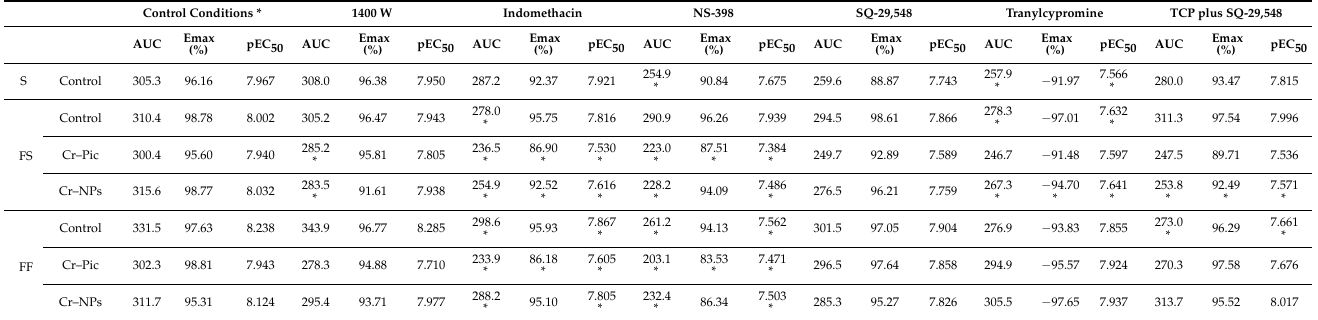
Table 2. The influence of inducible nitric oxide synthase (iNOS) inhibitor (1400 W at 1 µ M), the non- selective COX inhibitor (indomethacin at 10 µ M), the selective cyclooxygenase-2 (COX-2) inhibitor (NS-398 at 10 µ M), the thromboxane-A2 receptor (TP) antagonist (SQ-29,548 at 1 µ M), the PGI2 syn- thesis inhibitor (tranylcypromine, TCP at 10 µ M), or TCP plus SQ-29,548 on the vasorelaxant effects to acetylcholine of thoracic arteries of either chromium (Cr)-supplemented (9 weeks of supplementation) or not-supplemented (Control) rats. 0.3 mg Cr/kg of body weight as chromium picolinate (Cr–Pic) and chromium nanoparticles (Cr–NPs) were added after 9 weeks of experimental feed without Cr supplementation. Rats were fed a standard (S) diet for 18 weeks, and a high-fat–low-fiber (F) diet for either 9 weeks (FS group) or 18 weeks (FF group).